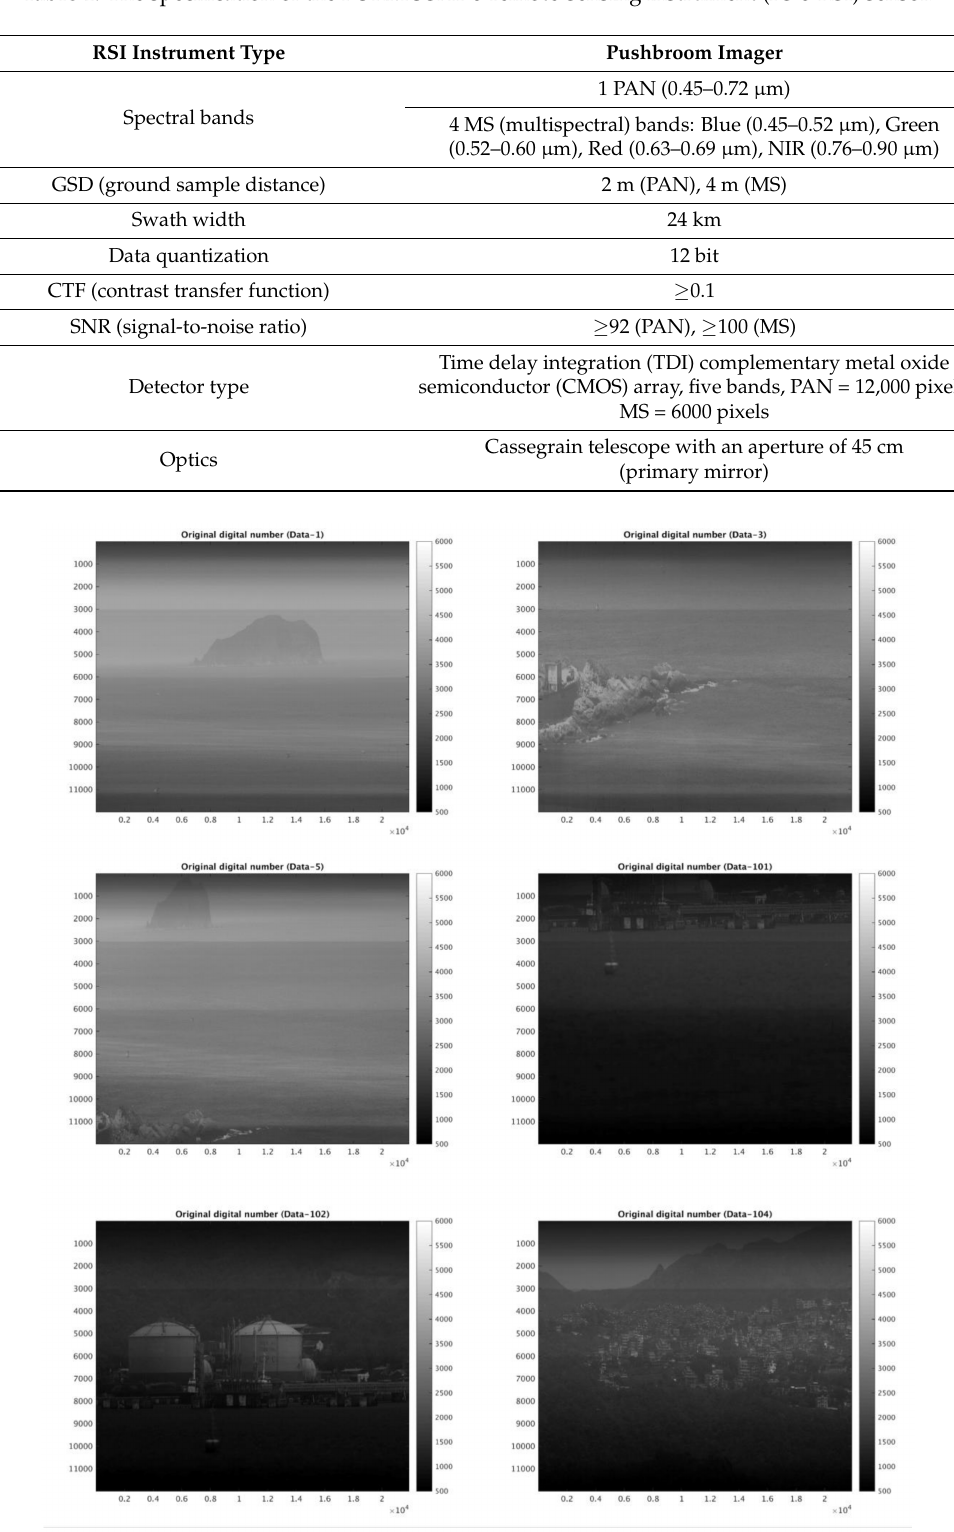
Figure 4. Field imagery from the digital mode sensor of FORMOSAT-5 provided by the National Space Organization (NSPO) for the testing of relative radiometric